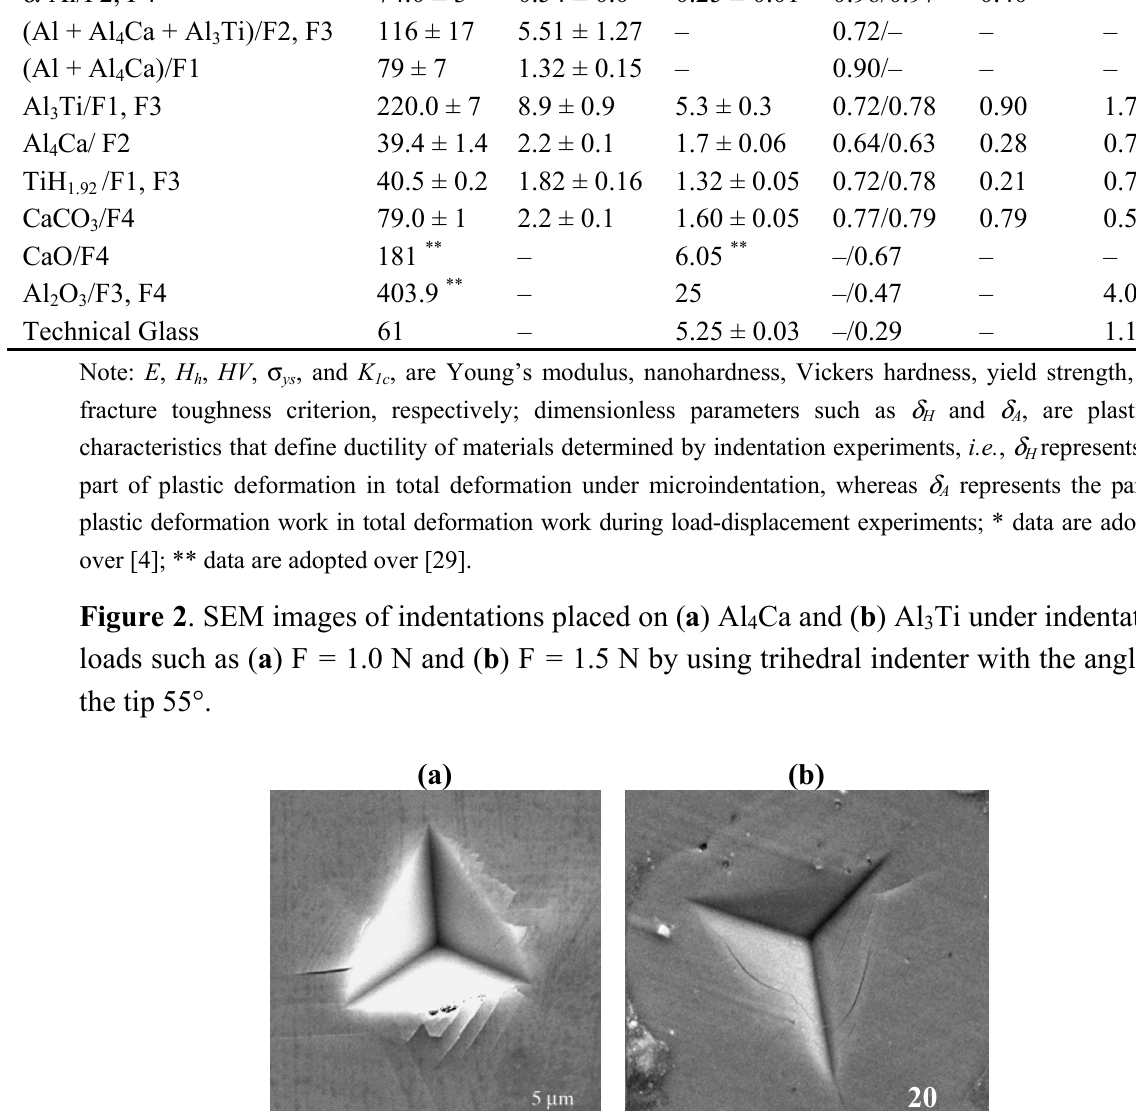
Table 2. Mechanical characteristics of the cell wall constituents and solid materials.